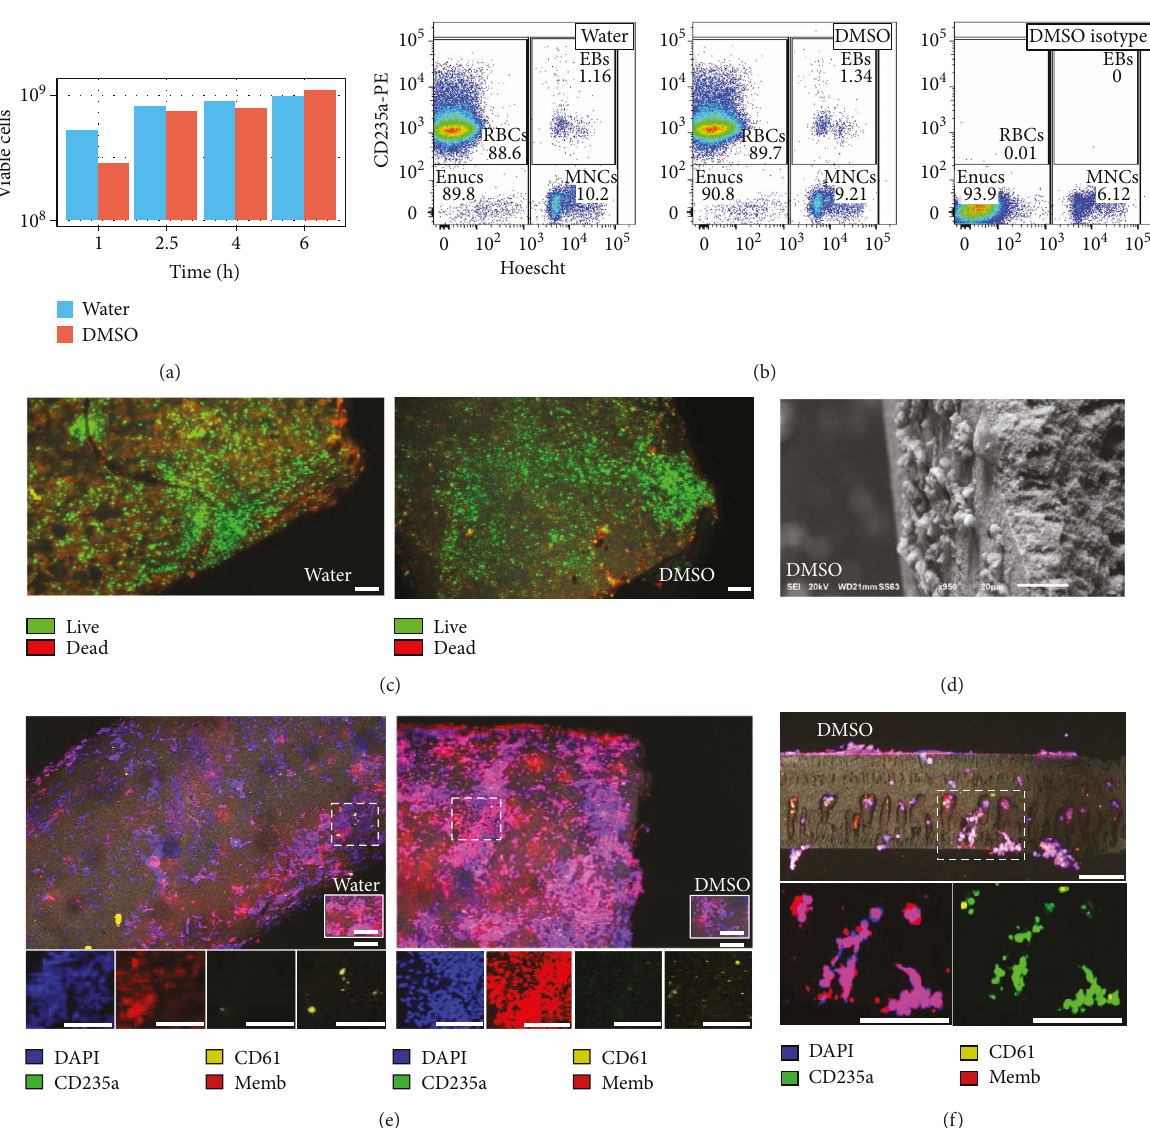
Figure 5: Dead-end fi ltration e ffi ciency. (a) Viable cell fi ltrate collection at 1, 2.5, 4, and 6 hours of fi ltration. (b) Filtrate cell types after 2.5 hours of perfusion for the (left) water and (center) DMSO fi bres with (right) DMSO fi bre isotype. (c) Comparison of cell viability within the water (left) and DMSO (right) fi bre using confocal microscopy with calcein AM (green), ethidium homodimer-1 (red), and laser re fl ectance (grey) (100 μ m scale). (d) SEM of outer, abluminal surface of the DMSO fi bre after 6 hours of dead-end fi ltration (20 μ m scale). (e) Comparison of cells remaining within fi bres after 6 hours of perfusion within the water (left) and DMSO (right) fi bre by confocal microscopy detection of nuclei (DAPI; blue), red blood cell marker CD235a (green), platelet marker CD61 (yellow), plasma membranes (CellMask; red), and laser re fl ectance (grey) and (below) single stains of hatched box regions (100 μ m scale). (f) Confocal images of a magni fi ed traverse section of the DMSO fi bre after 6 hours of fi ltration with (left) identical marker detection and (right) detecting only CD235a (green), CD61 (yellow), and laser re fl ection (grey) and (below) two stain images of nuclei and plasma membranes or CD235a and CD61 (100 μ m